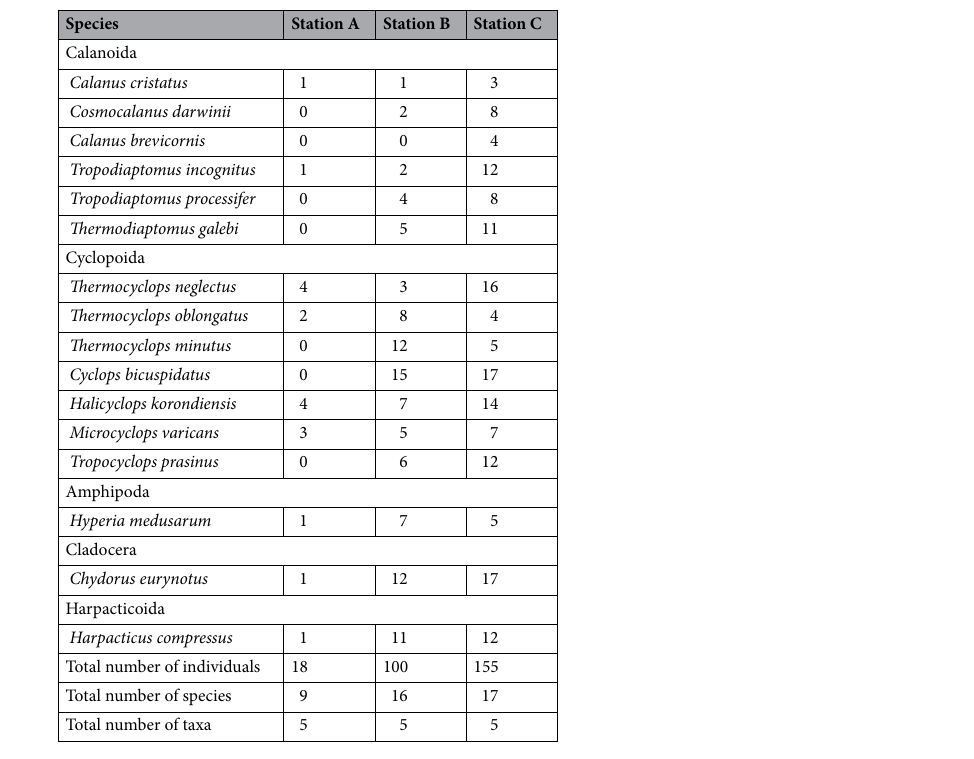
Table 4. Spatial distribution of